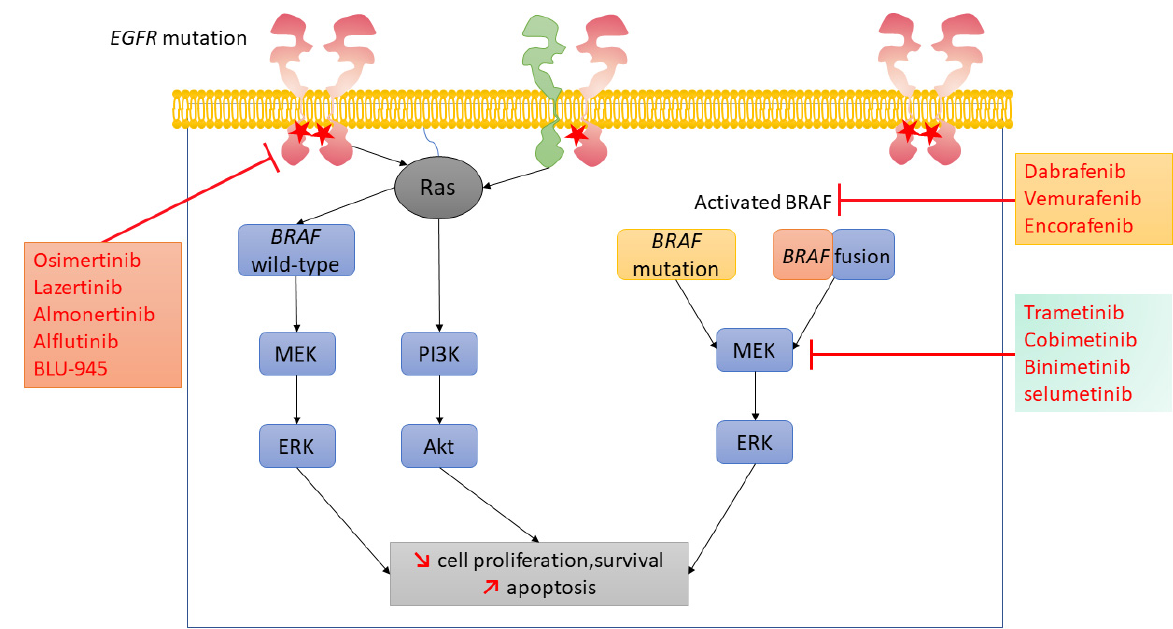
Figure 1. Triple targeted therapy suggestions in tumor cells harboring EGFR mutation and BRAF activation. Mutation in the EGFR gene leads to the EGFR receptor homo- or hetero-dimerization, which results in the activation of downstream effectors, including Ras–MAPK (with wild-type BRAF in blue) and PI3K-Akt, leading to increased cell proliferation and survival and decreased apoptosis. In a tumor cell harboring an EGFR mutation and a BRAF genetic alteration (mutation in yellow or fusion in blue/orange), BRAF can directly activate MEK, bypassing the Ras signaling and, therefore, leading to resistance to osimertinib. The combination of EGFR tyrosine kinase inhibitors (TKIs) and BRAF plus MEK kinase inhibitors induces EGFR/BRAF/MEK co-inhibition, which overcomes BRAF-acquired resistance mechanism ( BRAF mutation or fusion) to third-generation EGFR TKIs. Abbreviations: Akt, proto-oncogene c-Akt; BRAF, B-Raf proto-oncogene; EGFR, epidermal growth factor receptor; ERK, mitogen-activated protein kinase 2; MEK, mitogen-activated protein kinase 1; PI3K, phosphatidylinositol 3-kinase; Ras, ras sarcoma viral pro-to-oncogene; MAPK, mitogen activated protein kinase. Table 1. BRAF gene alterations in untreated non-small-cell lung cancer (NSCLC) and pilocytic as- trocytoma.